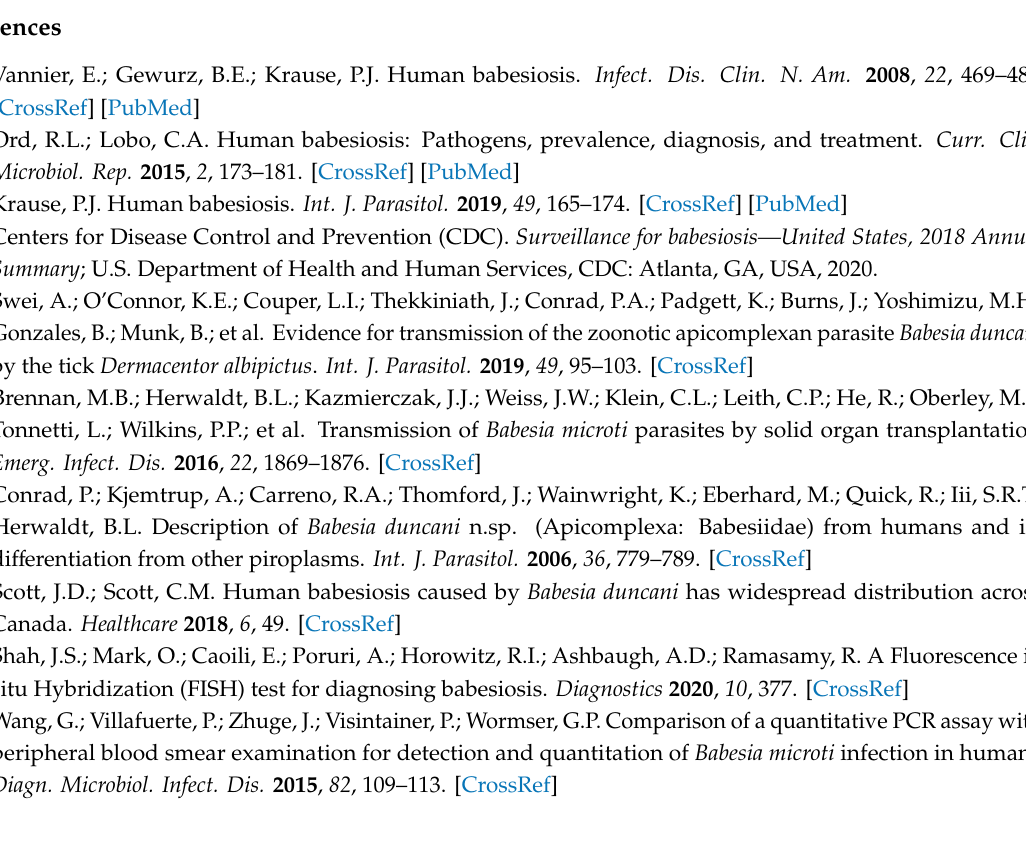
Figure S1. Results of FISH and IFA tests on patient samples from the US states and Puerto Rico; Figure S2. Results of FISH and IFA tests on patient samples from Australia, Europe and other